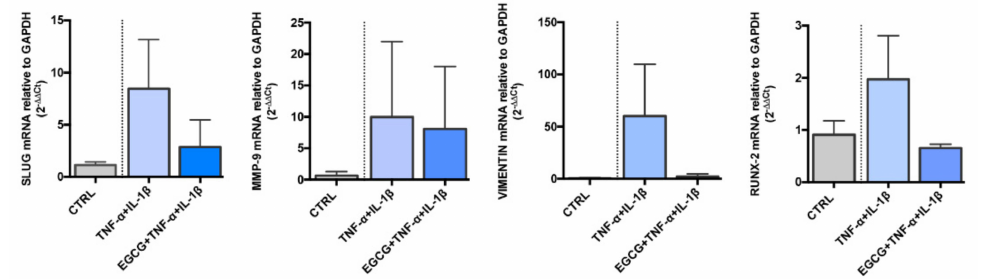
Figure 5. EGCG modulates the effects of inflammation in HUVEC grown with PLLA electrospun mat. Gene expression analysis of SLUG, MMP-9, VIMENTIN and RUNX-2 performed by Real Time PCR in HUVEC cultured with PLLA for 48 h, and exposed to inflammatory stimulation (TNF- α /IL-1 β ) ± EGCG (25 µ M) addition for further 72 h. Results are reported as fold changes relative to untreated HUVEC grown in presence of PLLA. Data are expressed as mean ± SD of at least 3 independent experiments. EGCG: epigallo-catechin-3-gallate; HUVEC: human umbilical vein endothelial cells; IL-1 β : interleukin 1-beta; PLLA: poly-L-lactic acid; TNF- α : tumor necrosis factor